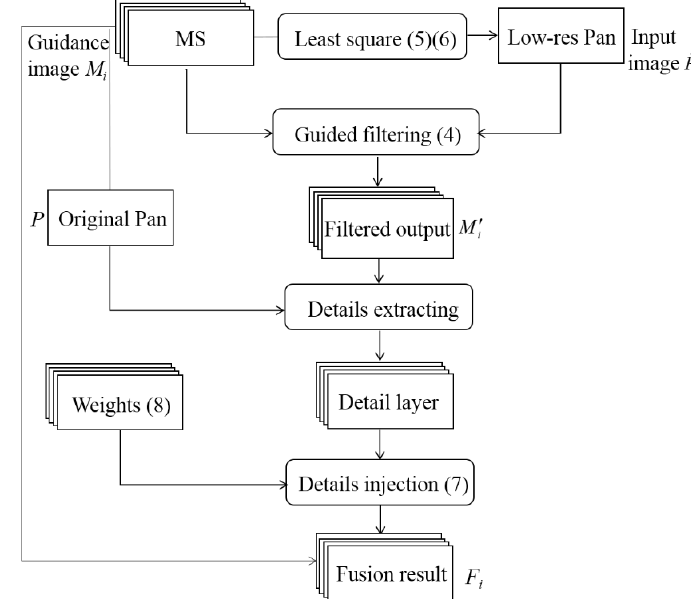
Figure 1. The processing flowchart of the proposed pan- sharpening